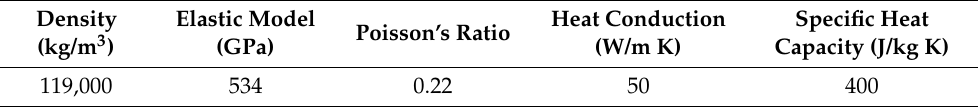
Table 3. Physical parameters of the cemented carbide cutting tools